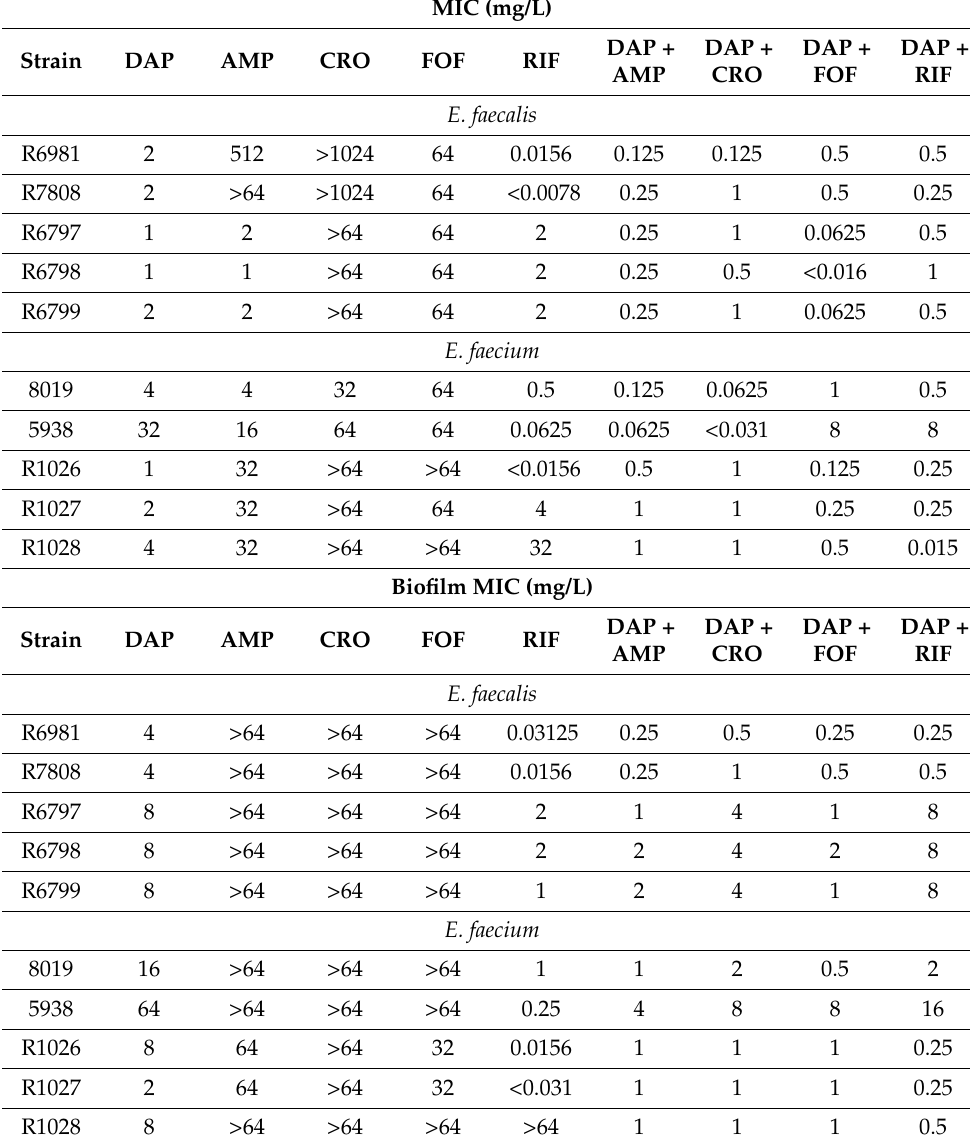
Table 1. Standard and Biofilm Minimum Inhibitory Concentrations